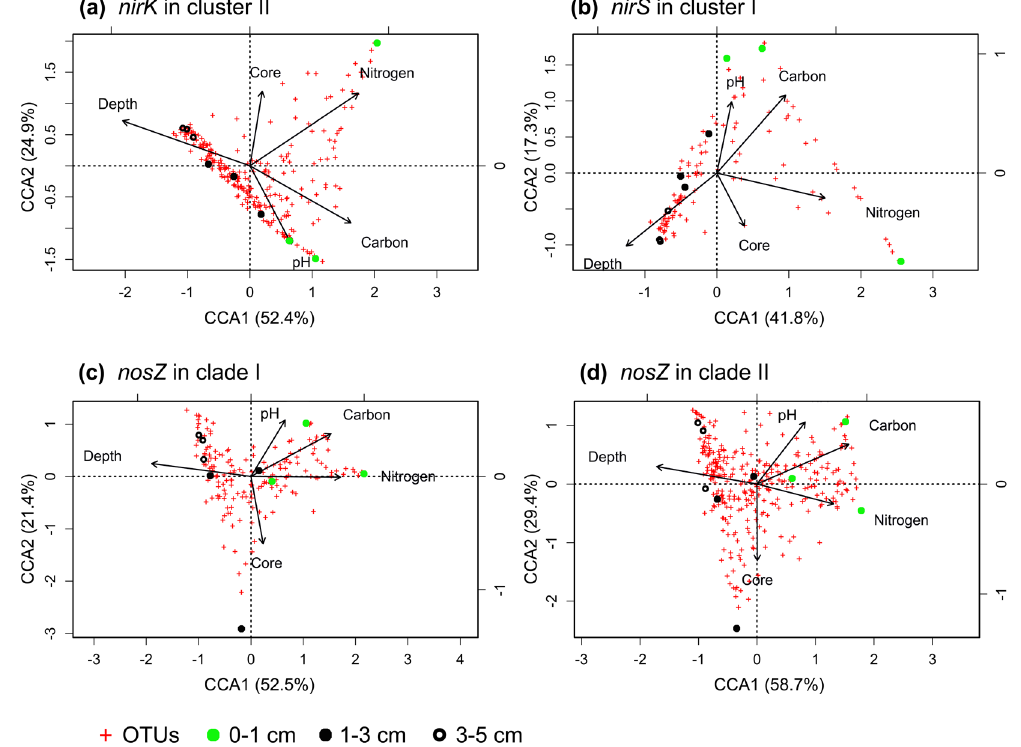
Figure 5. Evaluation of the effect of environmental factors on microbial communities harboring nirK in cluster II ( a ), nirS in cluster I ( b ), nosZ in clade I ( c ), and nosZ in clade II ( d ) in − 99-h soil cores by constrained correspondence